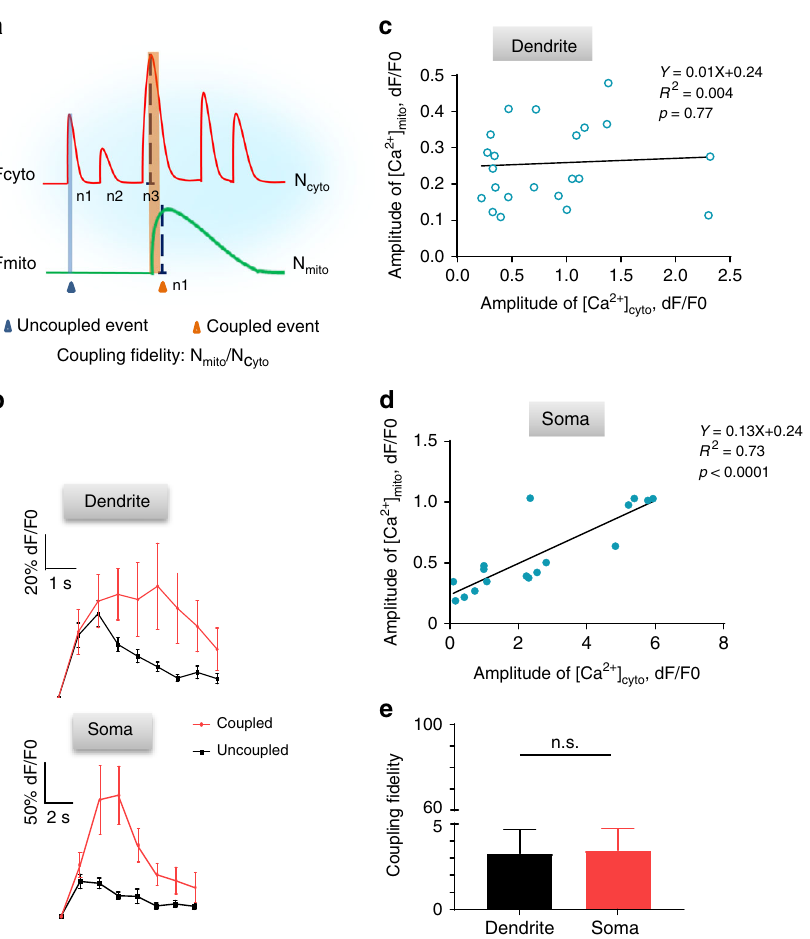
Fig. 3 Dynamic coupling of [Ca 2 + ] mito to [Ca 2 + ] cyto transients in neurons in vivo. a Schematic showing [Ca 2 + ] cyto transients with or without coupled [Ca 2 + ] 2 + transients observed. Coupling fi delity is de fi ned as N mito transients. N cyto or N mito : number of cytosolic or mitochondrial Ca mito /N cyto × 100%. b Averaged [Ca 2 + ] cyto transients in dendrites (upper panel) and somas (lower panel). 10 – 29 traces were used for each group. c , d Correlation of amplitudes of [Ca 2 + ] cyto and [Ca 2 + ] mito transients for coupled events in dendrites ( c ) and somas ( d ). ( c : n = 23 paired events from 6 mice; d : n = 17 paired events from 8 mice). e Coupling fi delity in dendrites and somas ( n = 47 from 6 mice in dendrites, n = 23 from 8 mice in soma). Data are presented as mean ± SEM. *P < 0.05. **P < 0.01. ***P < 0.0001, unpaired T -test. n.s.: no signi fi cance. Source data are provided as a Source Data fi